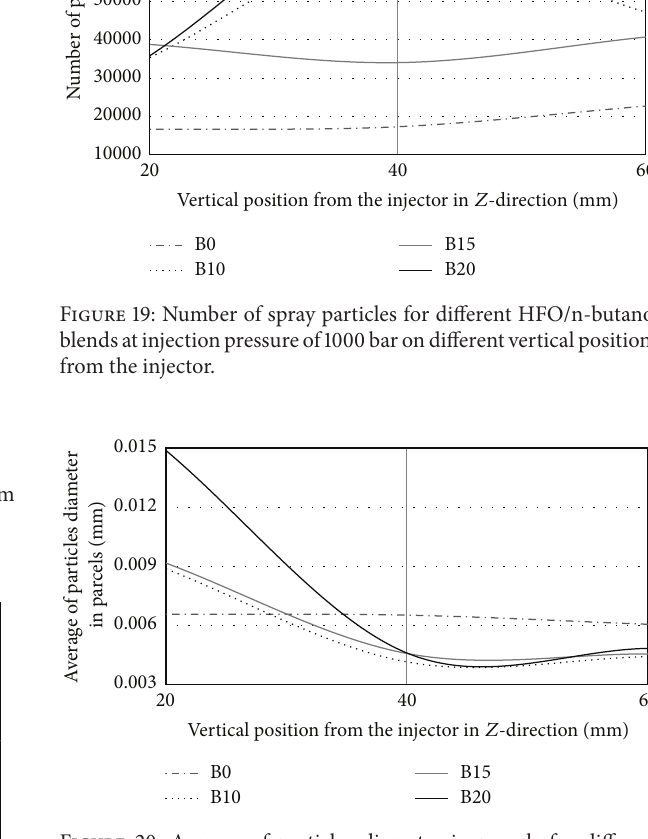
Figure 20: Average of particles diameter in parcels for different HFO/n-butanol blends at injection pressure of 600 bar on different vertical positions from the